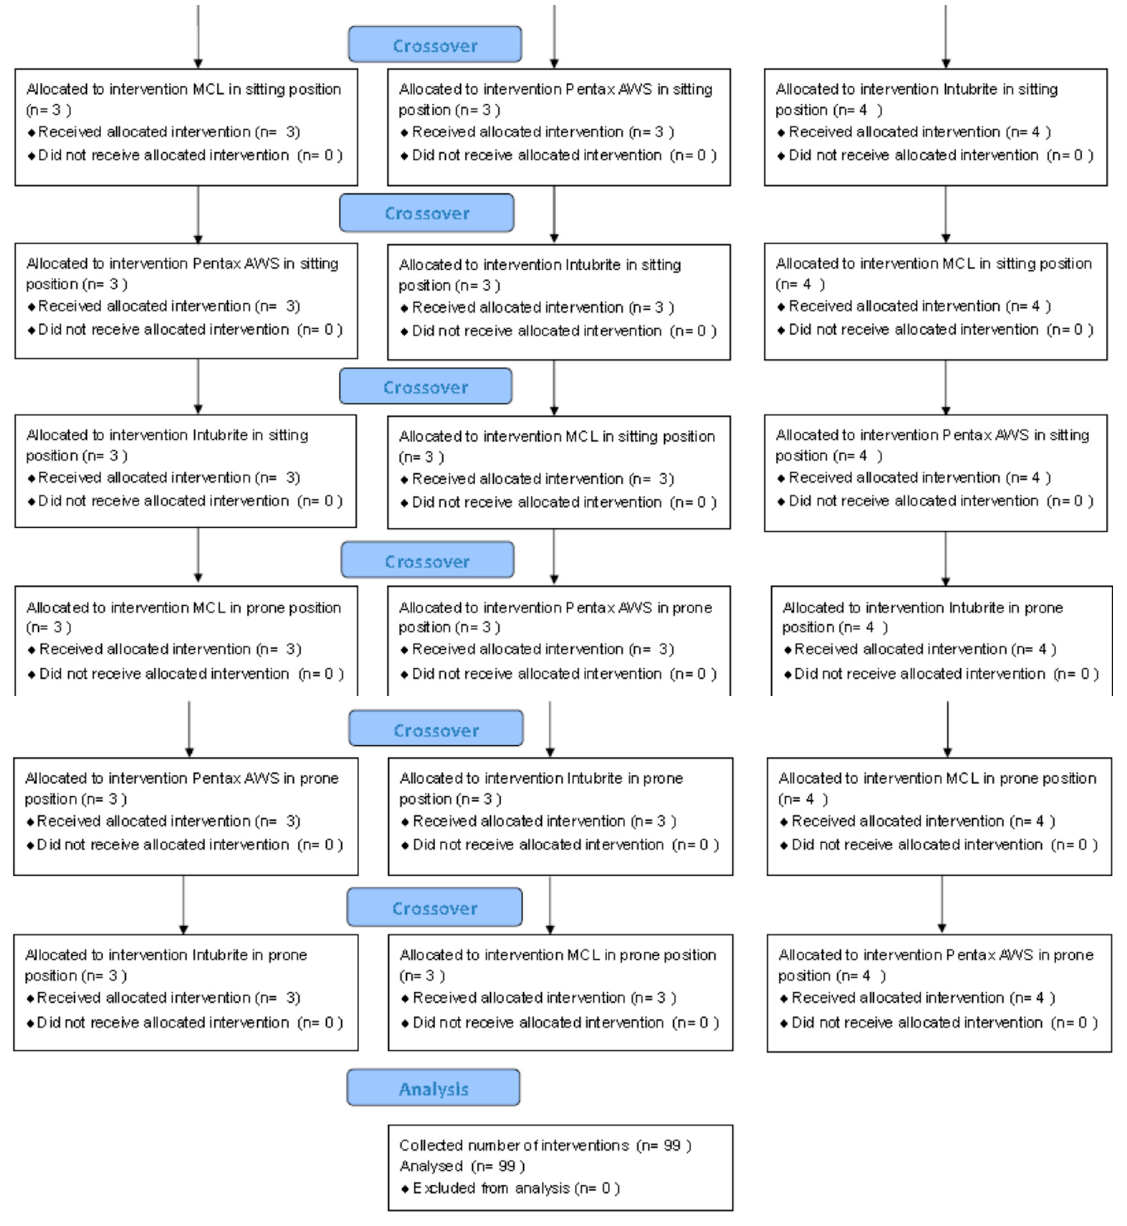
Figure 1. The CONSORT 2010 Flow Diagram.